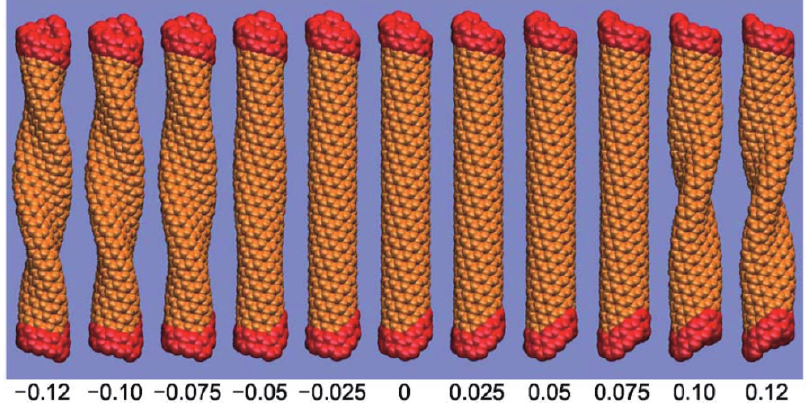
Figure 16. Morphological changes for a (8 , 3) nanotube under torsion. Applied strain and its direction are indicated beneath the diagram; the digit 0.05, for example, corresponds to the strain of 5%, and the sign + ( − ) indicates right(left)-handed rotation. Under right-handed rotation, the tube buckles at a critical buckling strain γ γ = 4 . 3% under left-handed rotation. Reprinted from Reference [186]. cl